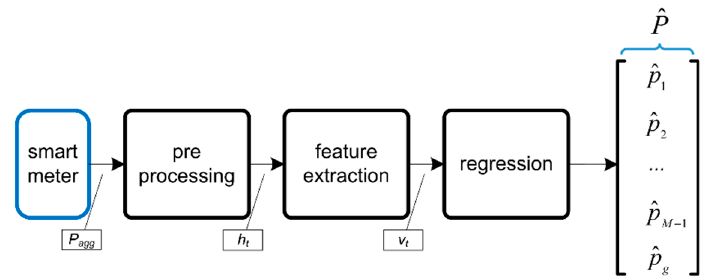
Figure 1. Block diagram of the baseline NILM architecture consisting of preprocessing, feature extraction, and regression estimation of power consumption.